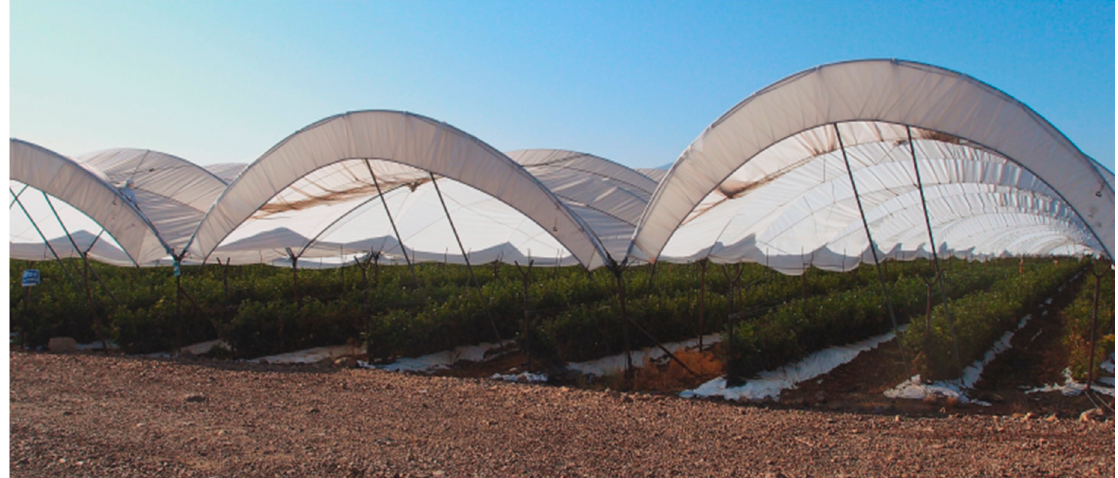
Figure 2. Open-sided commercial polytunnels used for experiments on trap-lure combinations for capture of D. suzukii in berry crops in Michoacán, Mexico.